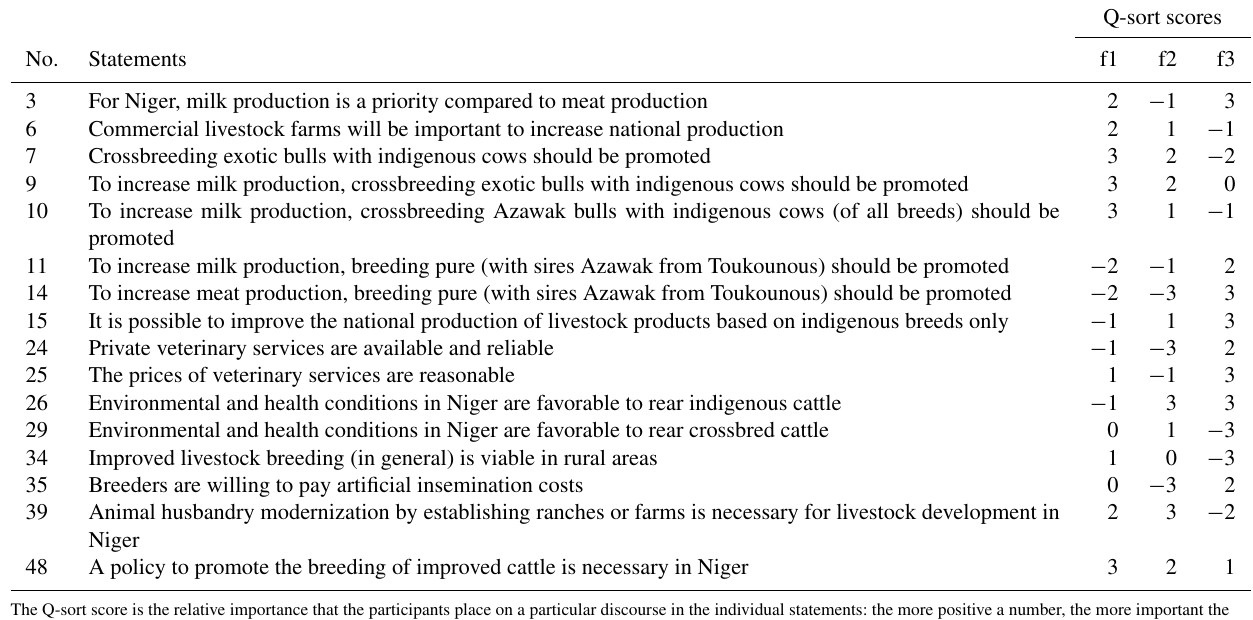
Table 2. Statements distinguishing all three